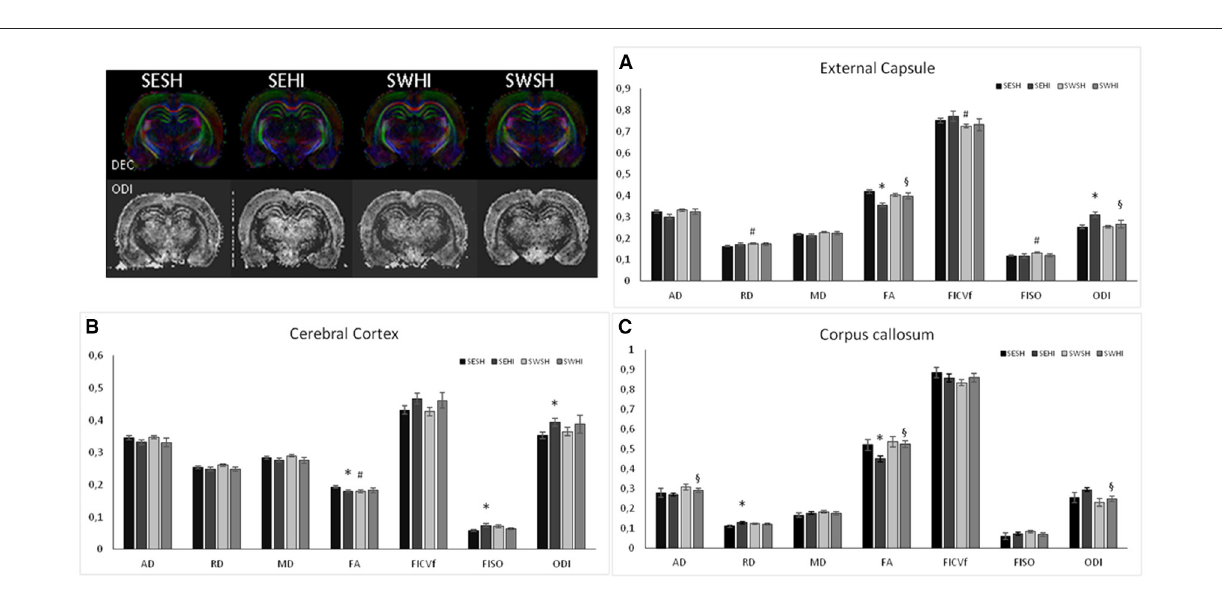
FIGURE 6 | Using ex vivo DT-MRI long-term microstructural white matter alterations were analyzed at PND60 following neonatal HI. White matter microstructure is partially restored by pregnancy swimming. Histograms of mean values ± SEM of DTI derived parameters: Axial Diffusivity (AD), Radial Diffusivity (RD), Median diffusivity (MD), fractional anisotropy (FA) and NODDI estimates: intraneurite volume fraction (ficvf), cerebrospinal volume fraction (fiso) and orientation dispersion index (ODI) in the external capsule (A) , cerebral cortex (B) , and corpus callosum (C) for SESH, SEHI, SWSH and SWHI rats at P60. *SEHI vs. SESH, # SESH vs. SWSH, § SEHI vs. SWHI; p <